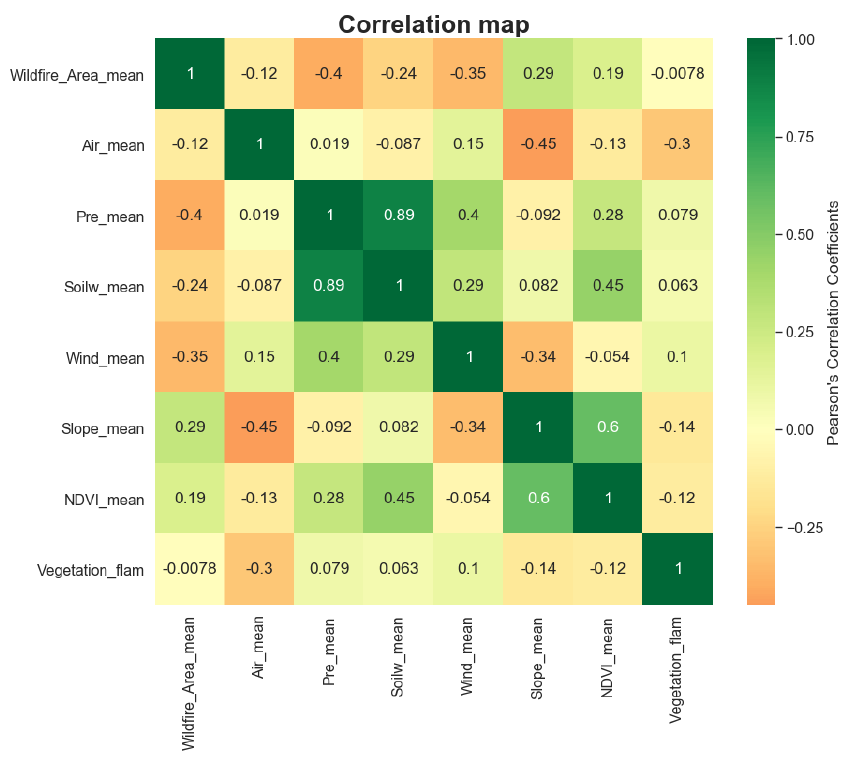
Figure 7. Pearson correlation coefficients of seven categories of influencing factors on the bushfire burned area.